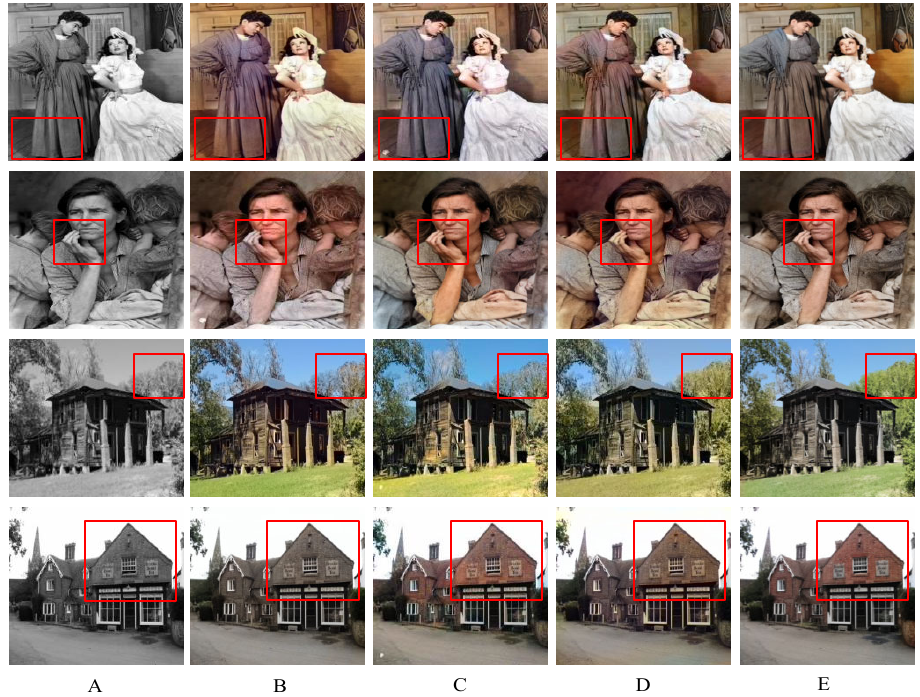
Figure 7. Comparison of the coloring effects of black and white old photos. ( A ) Grayscale image; ( B ) Ref. [13]; ( C ) Deoldify; ( D ) ChromaGAN; ( E ) Proposed method. The red rectangular box represents the area where the colorization effect of each method differs greatly.